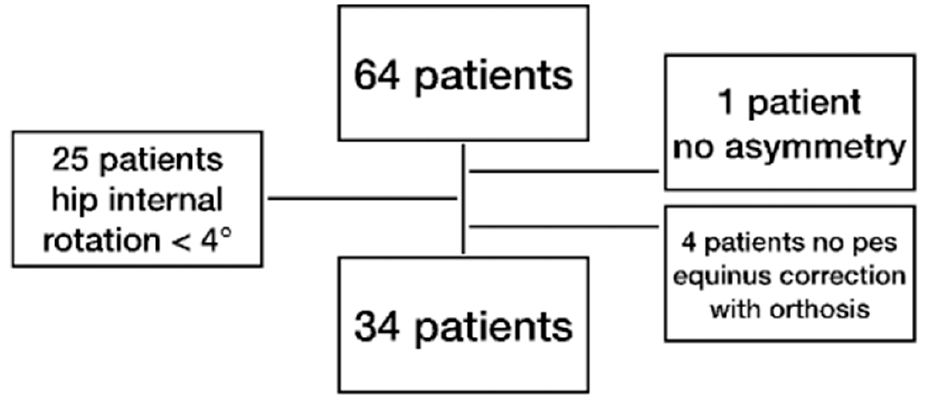
Figure 1. Schematic illustration of the inclusion of the patients. Middle row: number of patients; right and left row: number of and reason for excluded patients.